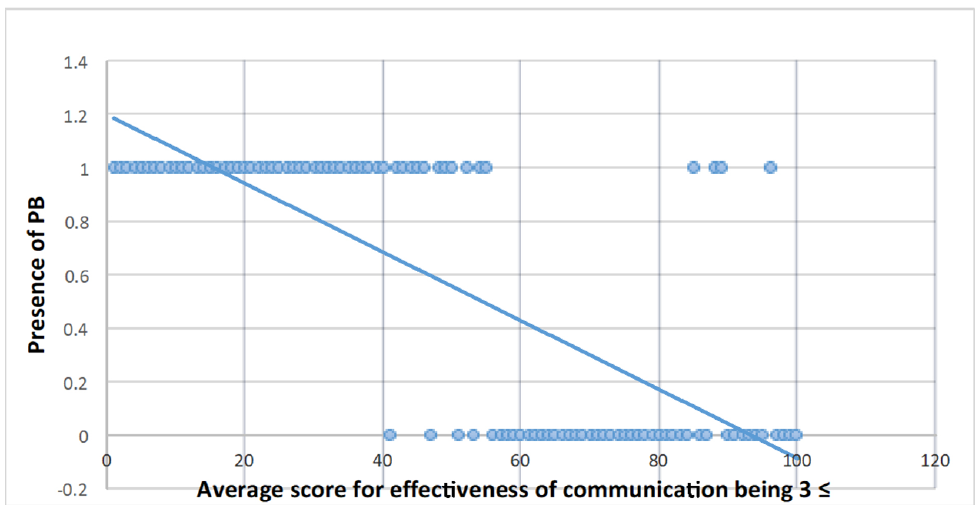
Figure 1. Scatter plot of incidence of PB and average effectiveness of communication score >